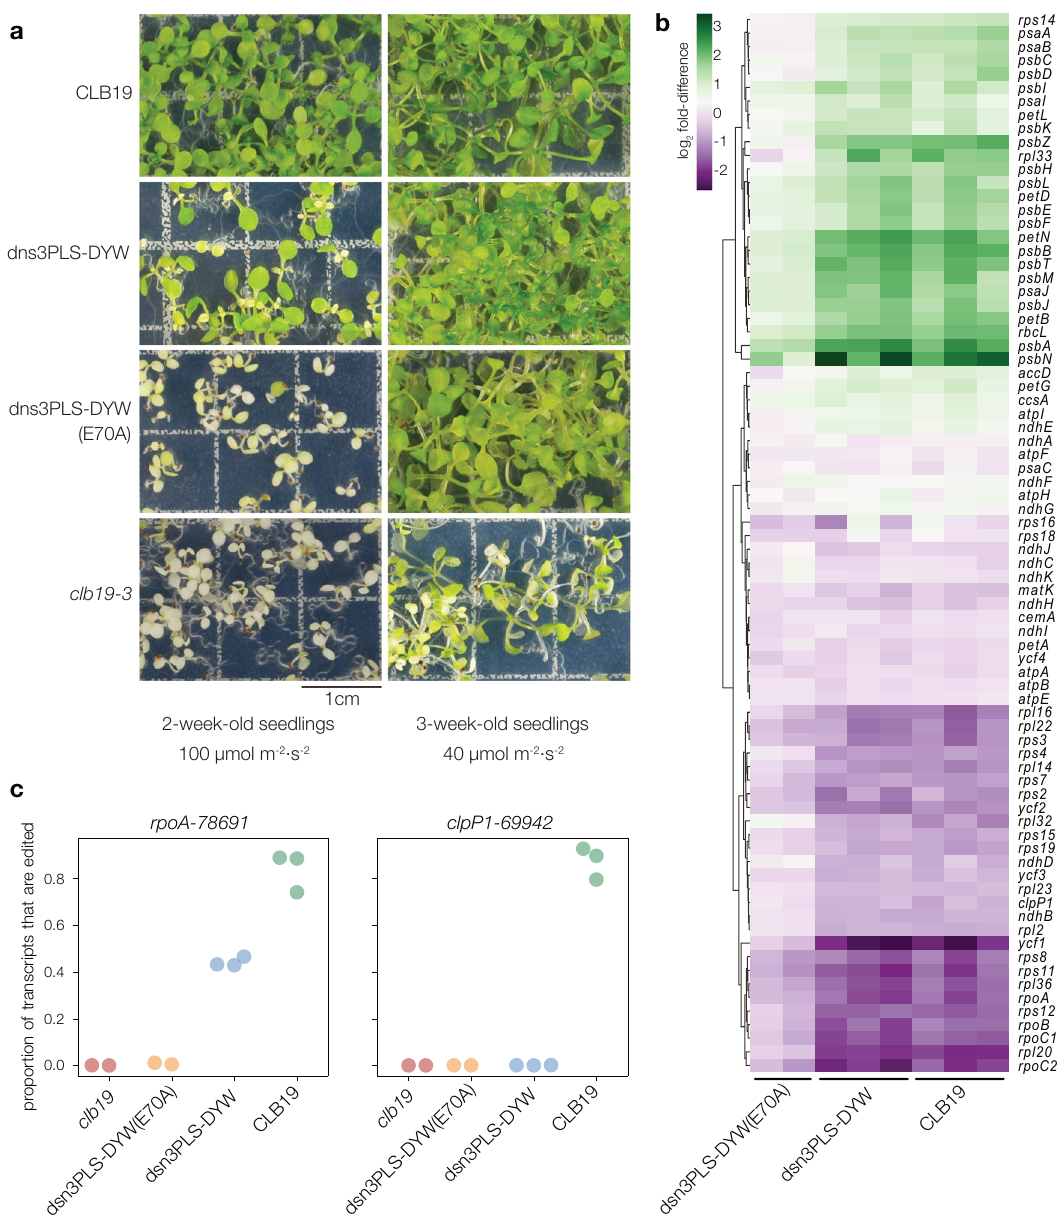
Fig. 3 Visible and molecular phenotypes of clb19 transformants. a Seedlings were grown under a 16 h photoperiod with a light intensity of either 100 µ mol m − 2 s − 2 (left panel) or 40 µ mol m − 2 s − 2 (right panel). The construct used to transform the clb19-3 mutant line is indicated on the left. The scale bar is 1 cm. b Chloroplast transcript abundances are shown as log 2 fold-difference compared to their levels in clb19 . The RNA was extracted from plants initially grown under low light. c RNA editing at the rpoA-78691 and clpP1-69942 sites in the four